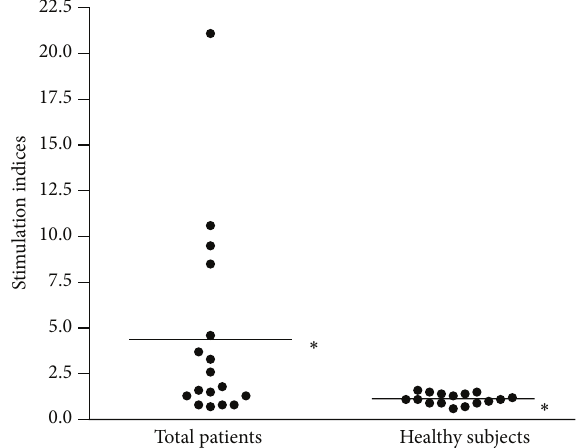
Figure 1: Proliferative response of peripheral blood mononuclear cell samples obtained from the 17 patients with carotid atheroscle- rosis and from the 16 healthy subjects. ∗ 𝑃 = 0.02 .